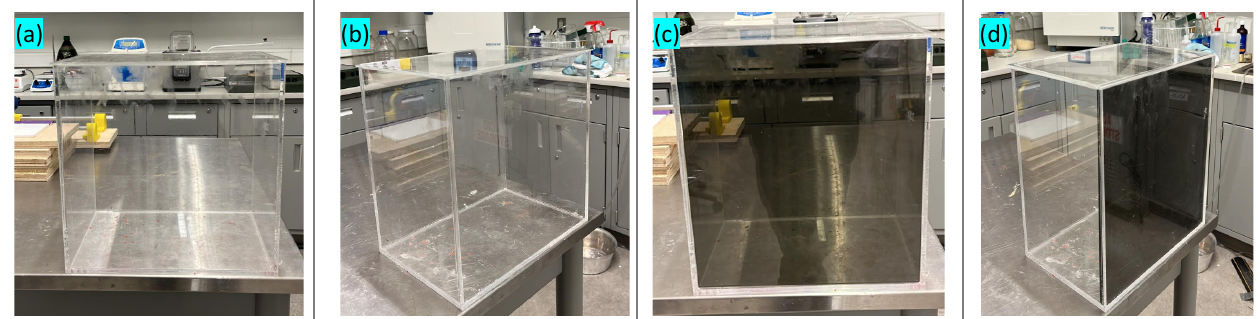
Figure 2. ( a ) Acrylic plexiglass water container (front view) ( b ) Acrylic plexiglass water container (view of side and front) ( c ) Acrylic plexiglass water container with tinted acrylic sheet (front view) ( d ) Acrylic plexiglass water container with tinted acrylic sheet (view of side and front).